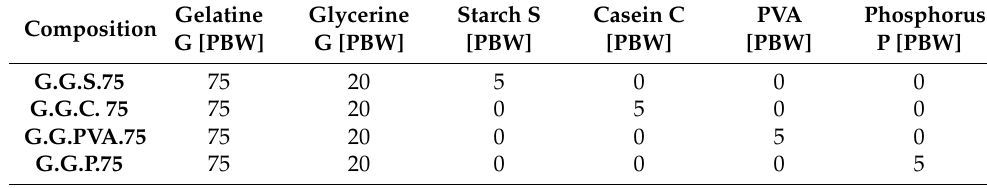
Table 2. Composition with fillers expressed in PBW.